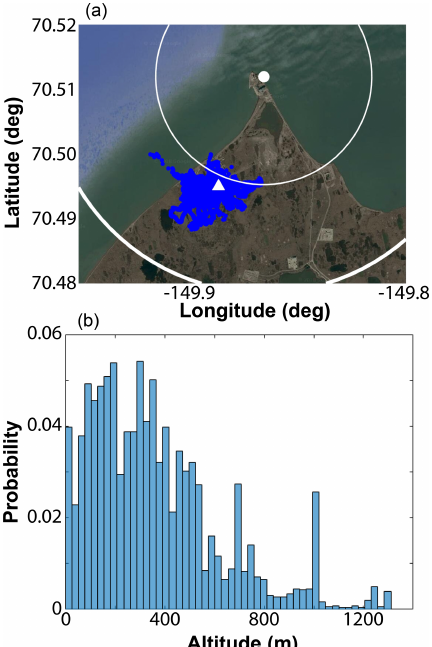
Figure 7. A spatial map of the POPEYE tethered balloon flight lo- cations ( a , blue dots), including white range rings at 1 and 2 nauti- cal miles demonstrating the extent of R-2204 and the location of the AMF-3 (white triangle). Panel (b) is a relative frequency distribu- tion of the altitudes sampled by the TBS during POPEYE. Satellite imagery was “Built with ©Google Maps”, using their Application Programming Interface (API).